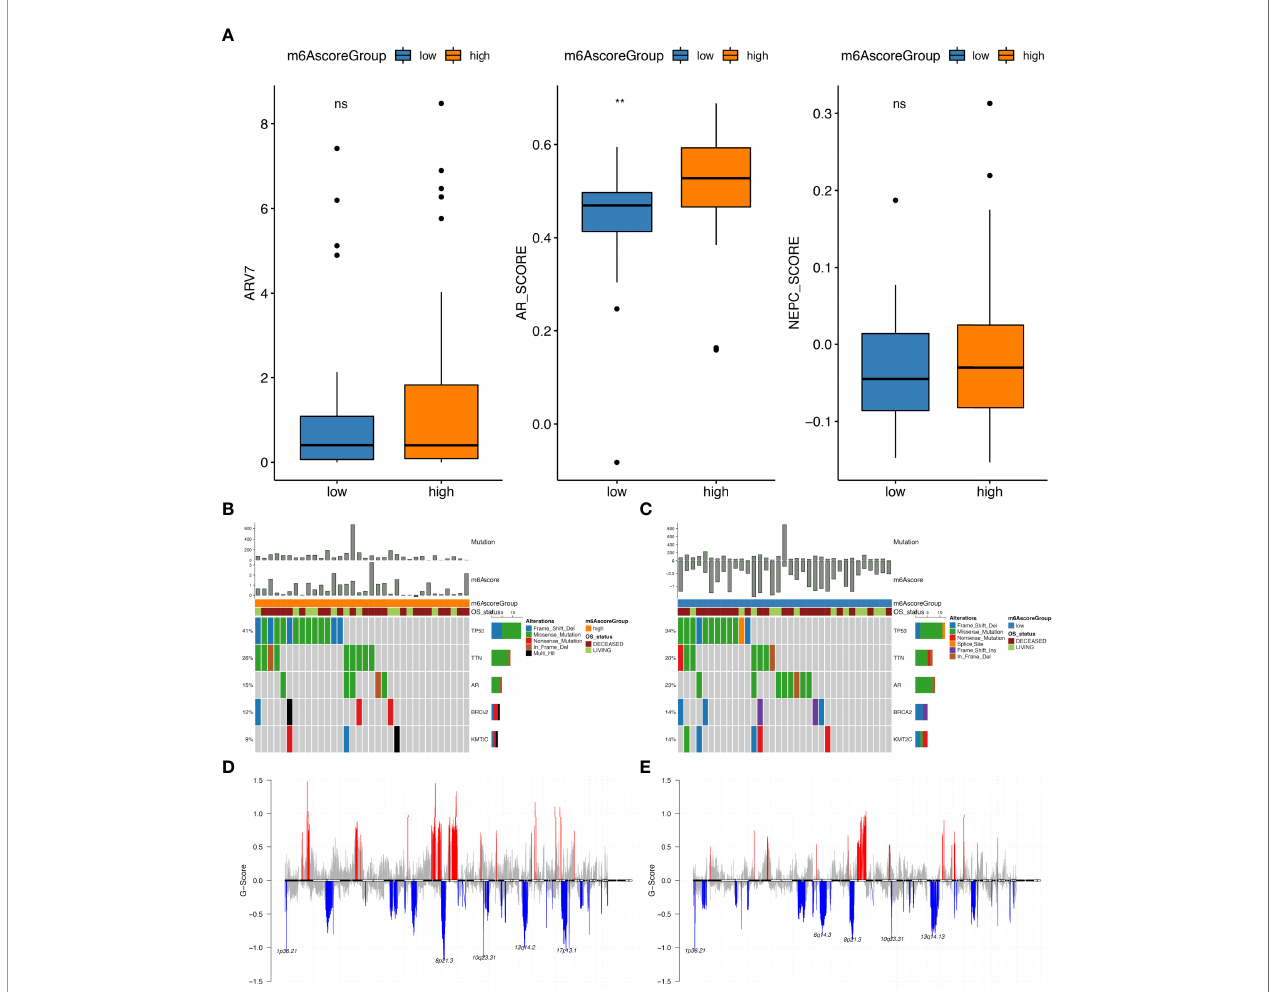
FIGURE 7 | Molecular pro fi ling of sample groups with high and low m6Ascore. (A) The distribution of ARV7 (middle), ARscore (middle) and NEPCscore (right) between samples with high and low m6Ascore; Gene mutation distribution of high (B) and low (C) m6Ascore samples; The distribution of copy number ampli fi cations and deletions in high (D) and low (E) m6Ascore samples. ns, no signi fi cance; **P ≤